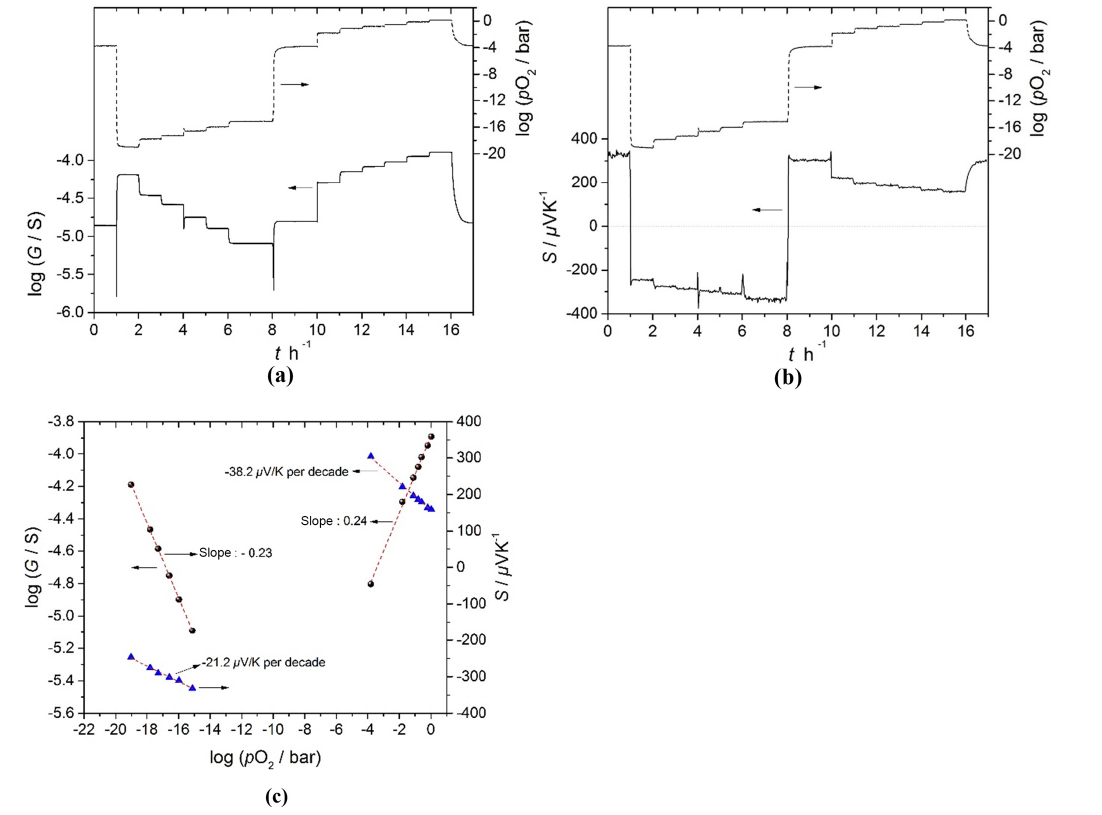
Figure 9. (a) Oxygen partial pressure dependence of conductance and (b) the Seebeck coefficient of BFAT30 AD thick film, and (c) sensor characteristics obtained from panels (a) and (b) as a point graph at 700 ◦ C in the p O 2 range 10 − 21